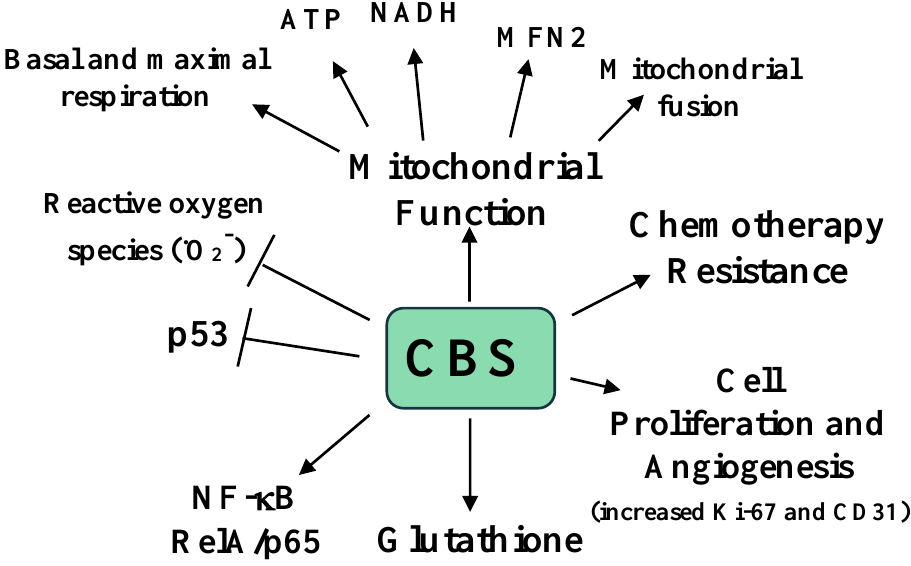
Figure 2. A summary of the roles of CBS and H2S in ovarian cancer growth, progression, metastasis, mitochondrial, function, and chemotherapy resistance. O 2 − is the superoxide radical [51].